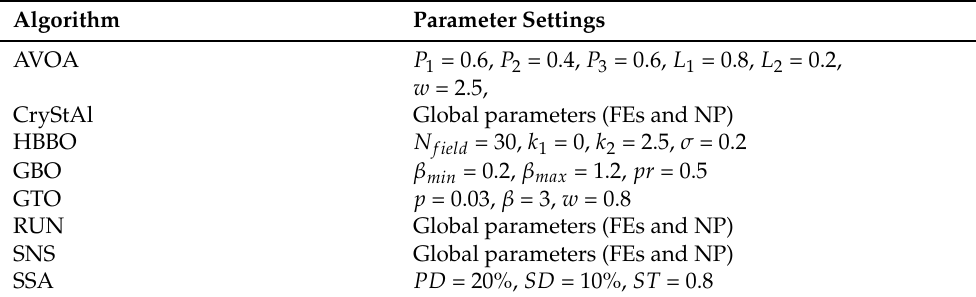
Table 1. Specific parameter settings of used algorithms.